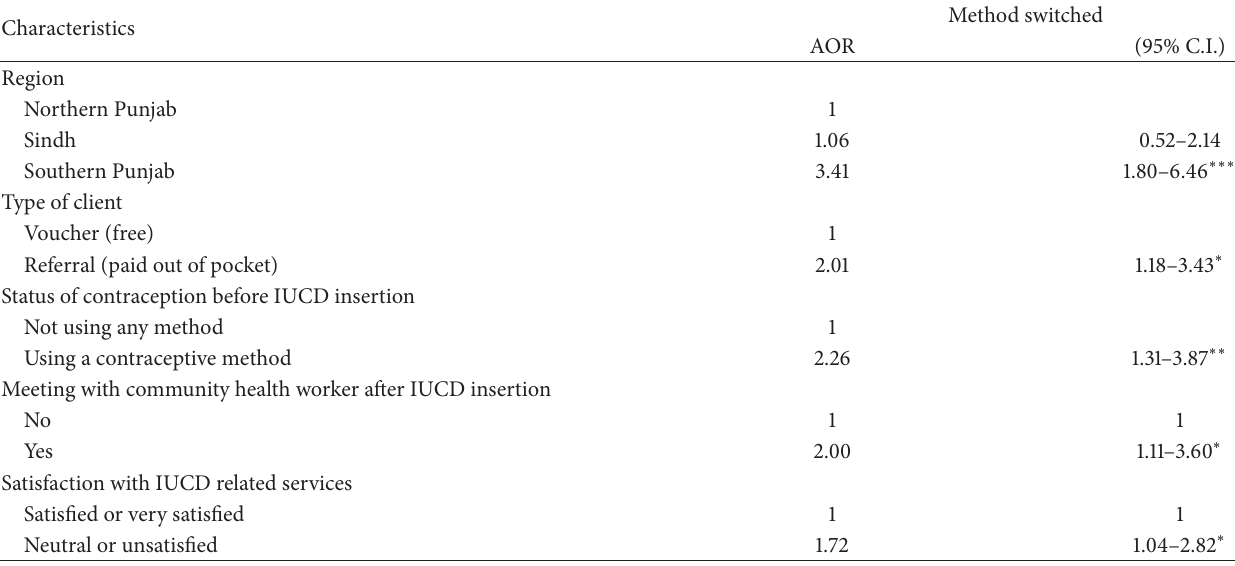
Table 4: Adjusted odds ratios of method switching versus method stopping, according to selected sociodemographic and reproductive health risk